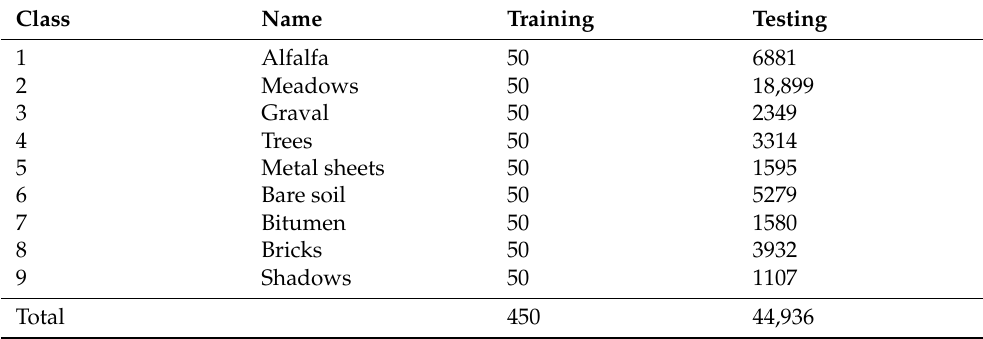
Table 3. Class-based numbers of training and testing samples for